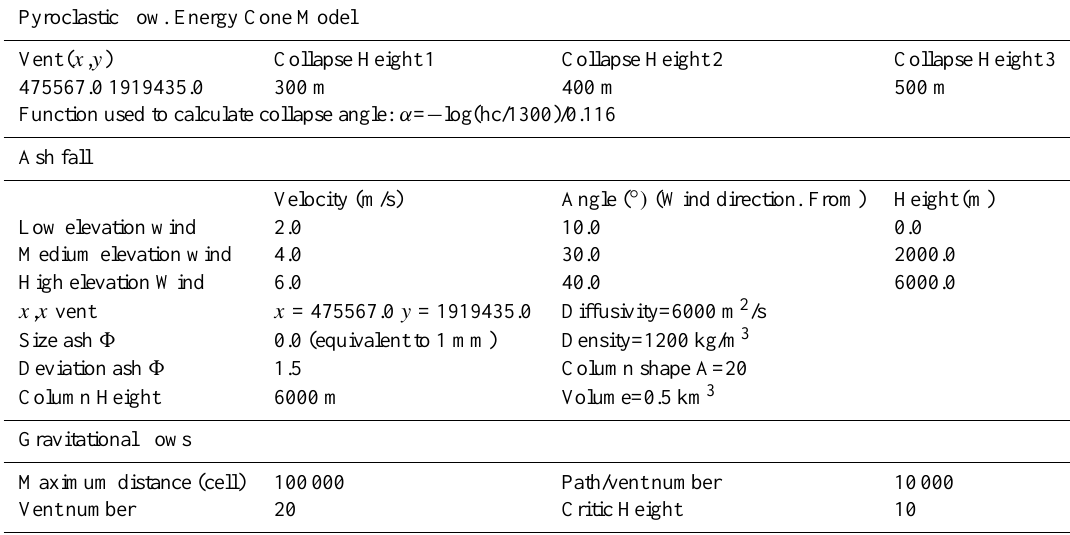
Table 3. Parameters used for the design of the hazard scenarios simulated with VORIS model (Felpeto et al., 2007; http://www.gvb-csic.es/